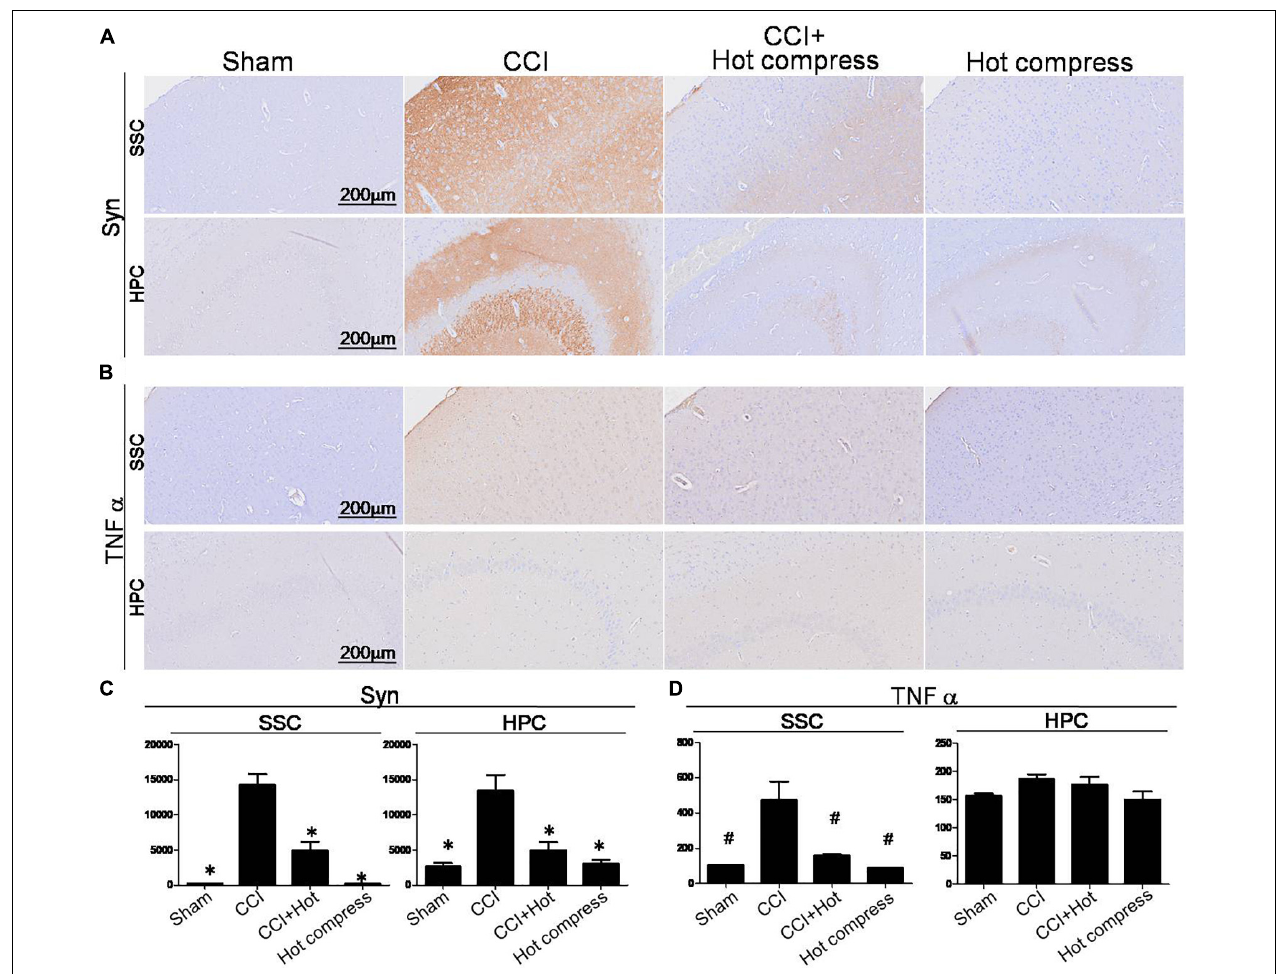
FIGURE 6 | Histological examinations of Syn and TNF α expression over the SSC and HPC regions in the brain on the 28th day. IHC staining for (A) Syn and (B) TNF- α , (A) quantitative analysis of the expression level of Syn in the brain SSC (left) and HPC (right), and (D) quantitative analysis of the expression level of TNF α over the SSC (left) and HPC (right). Somatosensory cortex, SSC; hippocampus (CA3), HPC. Data were analyzed by one-way ANOVA with post hoc Dunnett’s test. ∗ p < 0.001, # p < 0.05 was considered significant as compared with the CCI group, n = 8. Bar, 100 µ